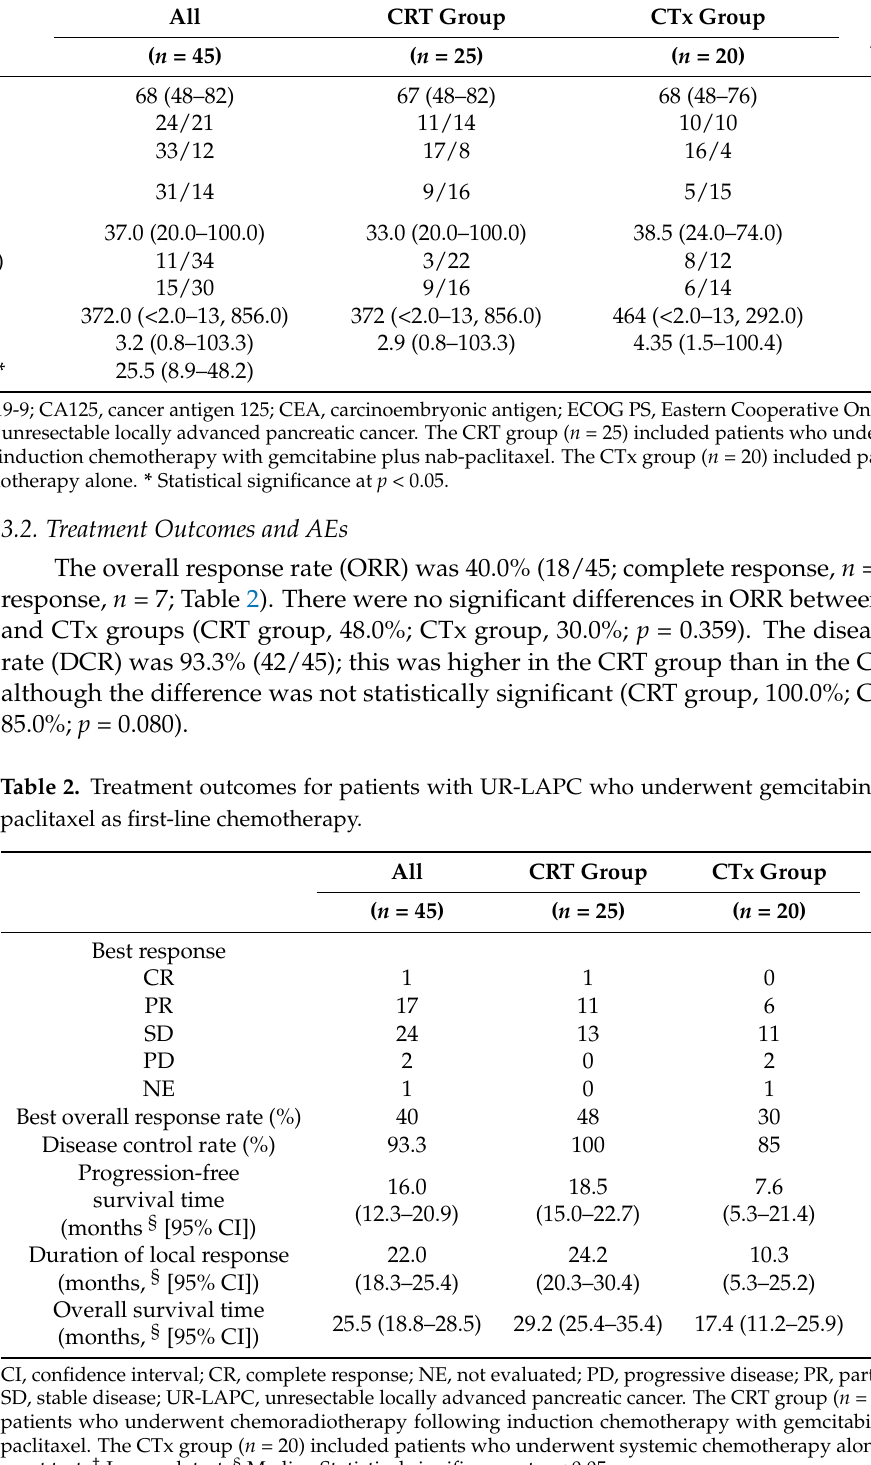
Table 1. Characteristics of patients with UR-LAPC who underwent gemcitabine plus nab-paclitaxel as first-line chemotherapy. All